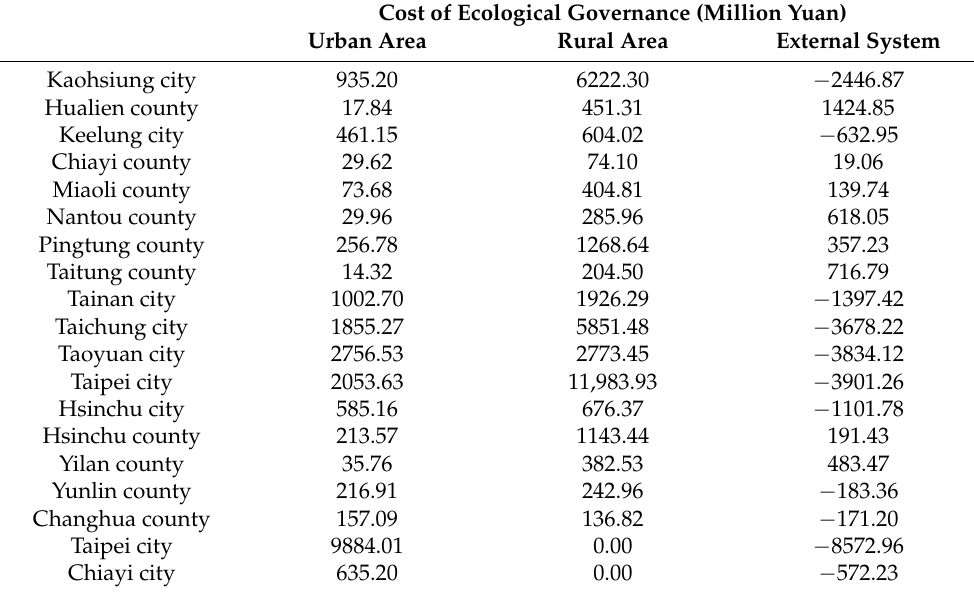
Table 3. Distribution of urban area’s cost of ecological